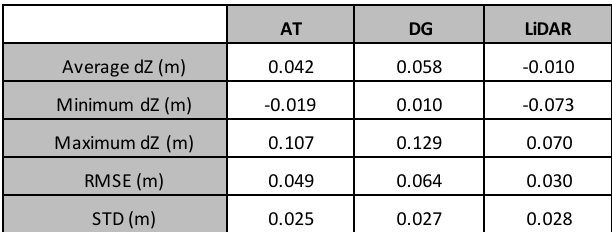
Table 5: Comparison of the CPs